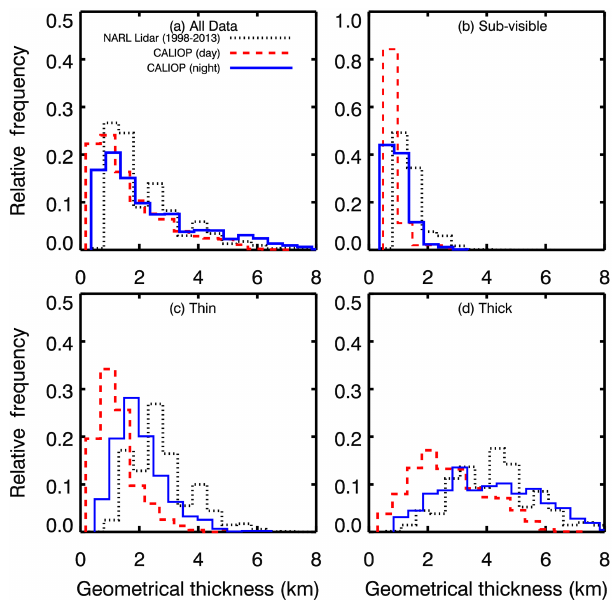
Figure 8. Histograms showing the frequency distribution of geo- metrical thickness in bins of 0.5km for (a) all cirrus cloud lay- ers, (b) sub-visible cirrus ( τ <0.03), (c) thin cirrus (0.03< τ <0.3) and (d) thick cirrus cloud layers ( τ >0.3) obtained from NARL Lidar (dotted black line), CALIOP daytime (dashed red line) and CALIOP night-time (solid blue line) data sets.